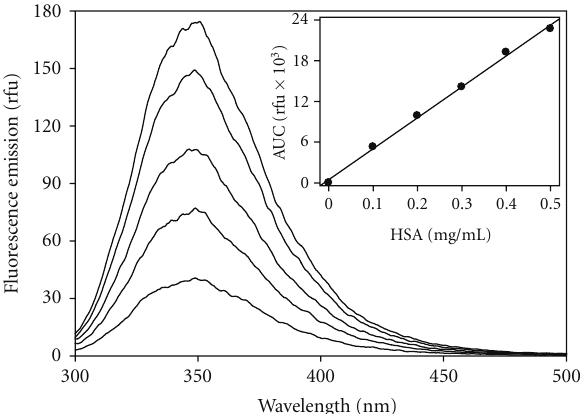
Figure 1: Fluorescence spectra at low HSA concentrations. Trypto- phan fluorescence spectra were obtained as described in Materials and Methods. Ascending tracings represent HSA at 0.1, 0.2, 0.3, 0.4, and 0.5 mg/mL, respectively. Inset, plot of the AUC (areas under the curve of entire spectral region) against HSA concentration ( r 2 = 0.997).